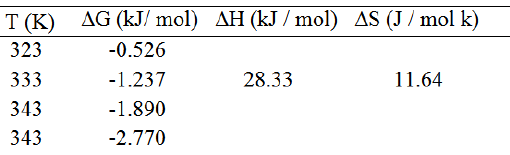
Table 3. Thermodynamic parameters of PSTM-3T at initial concentration of 10 mg / l,